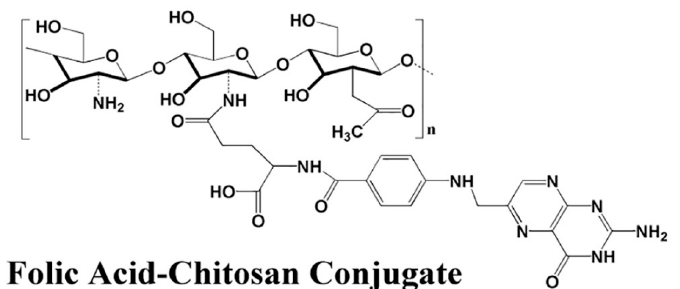
Figure 3. Formation of chitosan-folic acid conjugation through the amine group of chitosan and OH group of FA. Table 1. The effect of size, poly dispersity index, encapsulation efficiency (%) and loading content (%), and zeta potential on chitosan: Sorafenib ratios. Optimal parameters are shown in bold.